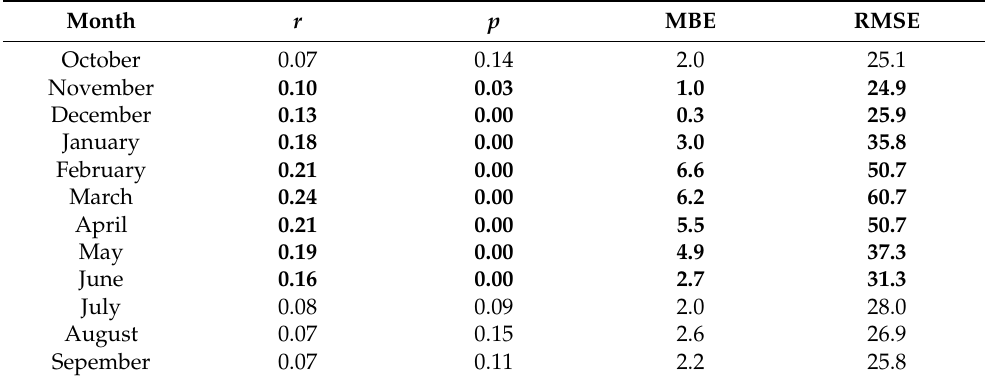
Table 2. Verification statistics for monthly 10th percentile values of NWM retrospective simulated streamflow relative to associated USGS observations. Months where the Spearman correlation coefficient is significant at p < 0.05 are in bold. Units of MBE and RMSE are m 3